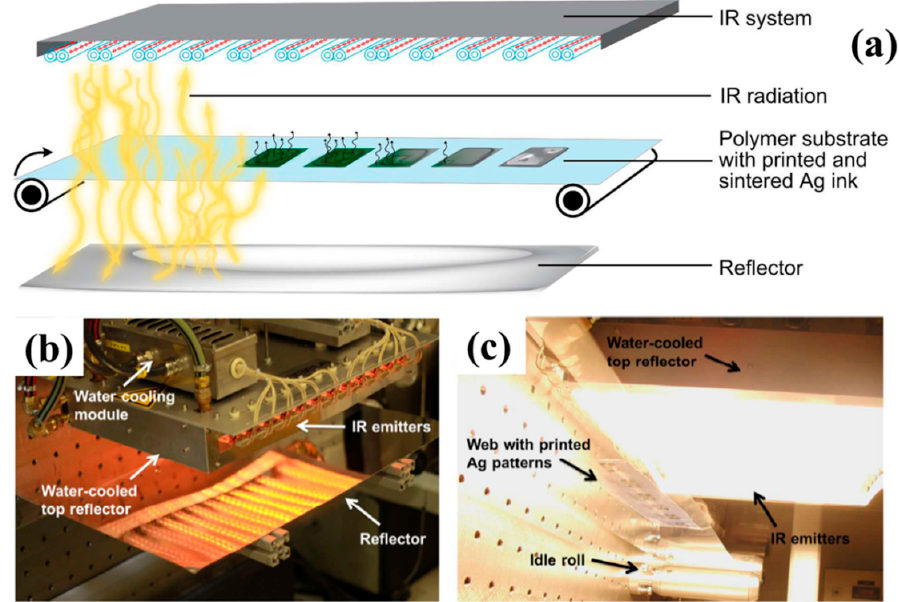
Figure 7. ( a ) scheme of the experimental setup of roll to roll (R2R) IR drying and sintering of inkjet-printed Ag NPs layers on Polyethylene naphthalate (PEN) substrates. The R2R sintering instrument in ( b ) top view and ( c ) from below with activated IR radiation. Reproduced with permission from [81]; Copyright 2015 Royal Society of Chemistry.